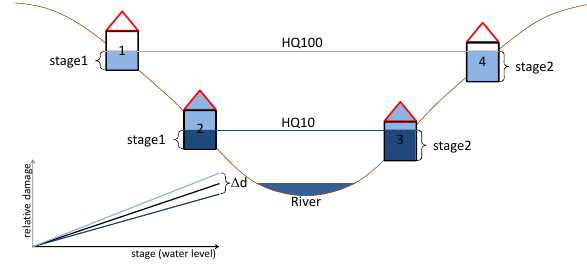
Fig. 2. Object losses caused by floods of different